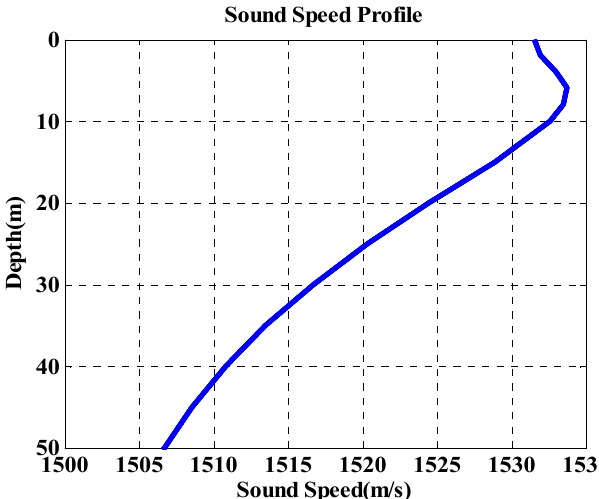
Figure 9. Sound velocity profile for the simulation.